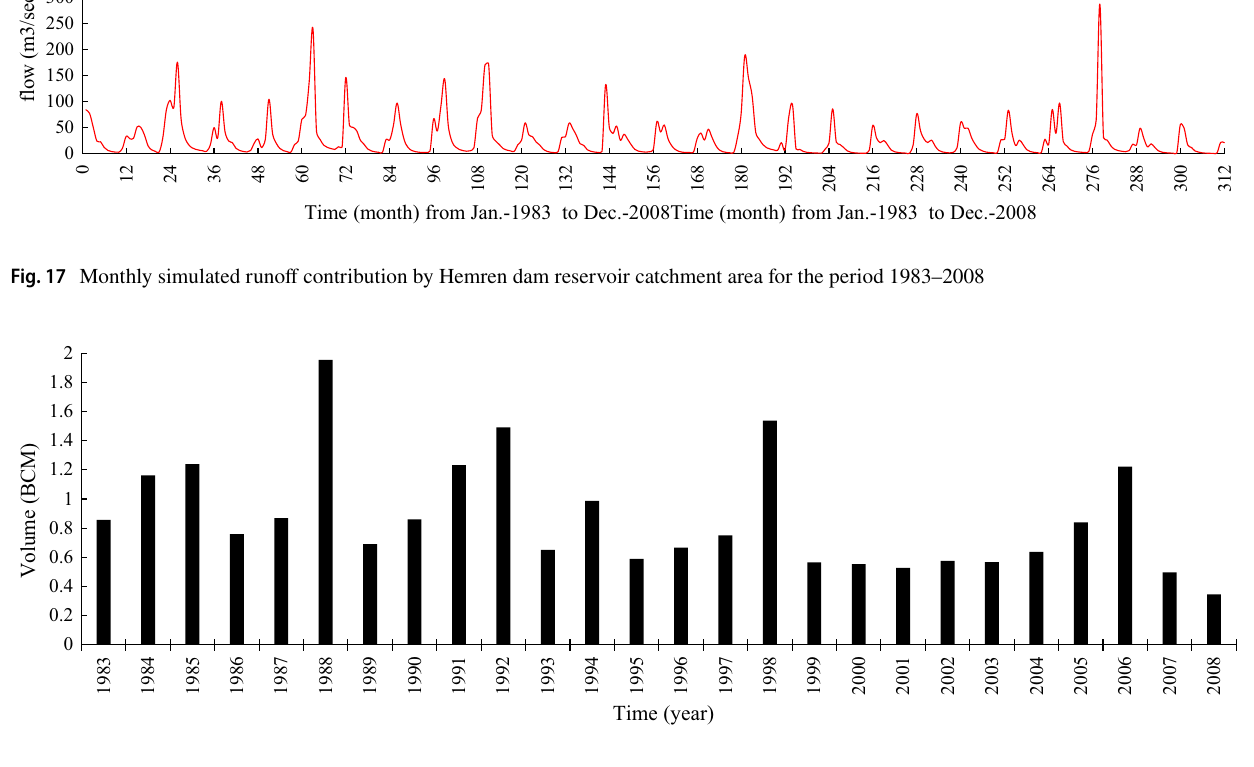
Fig. 19. In this study, results show that the evapotranspiration is the main process that causes very high percent (84%) of pre- cipitation to be lost from the surface although the soils in the